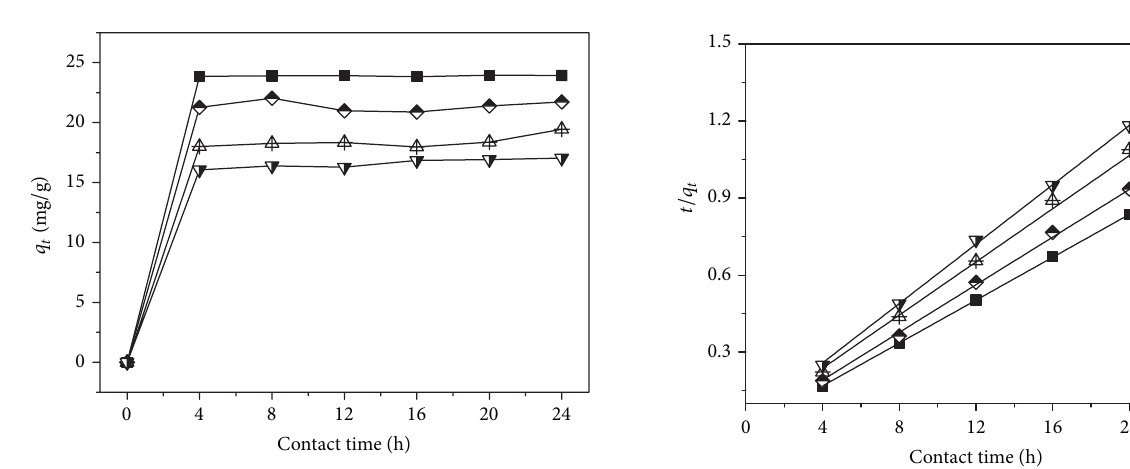
Figure 2: Lagergren pseudo-second order kinetic model for the adsorption of strontium ions on samples A (solid square), B (half- filled diamond), C (center up triangle), and D (half-filled down